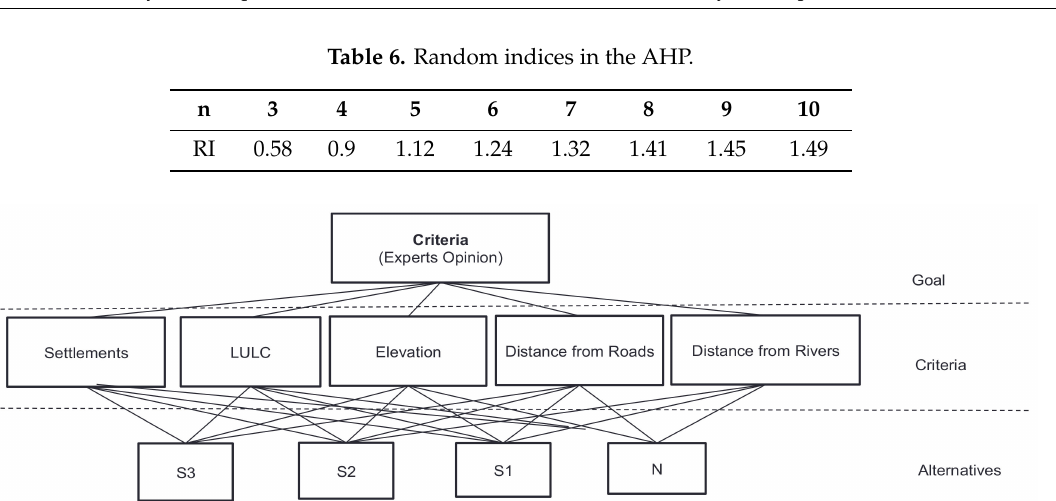
Figure 5. The AHP framework to incorporate expert opinion into the land suitability analysis for extension of potential forest